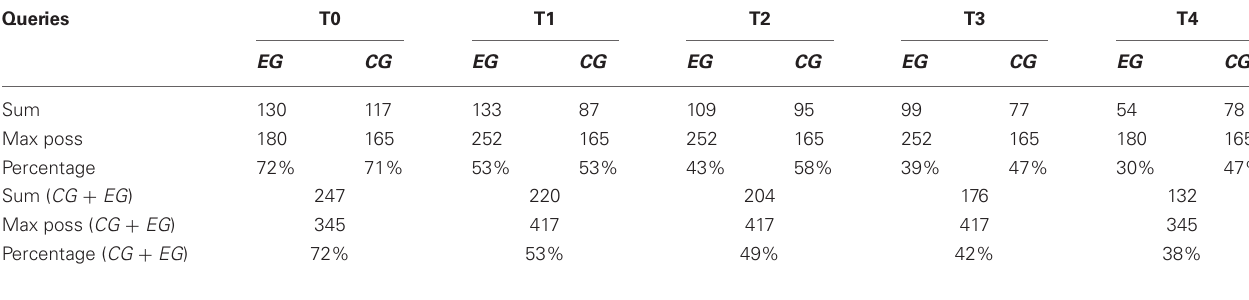
Table 3 | Compliance to mood assessments at the different times of measurement (T0–T4).